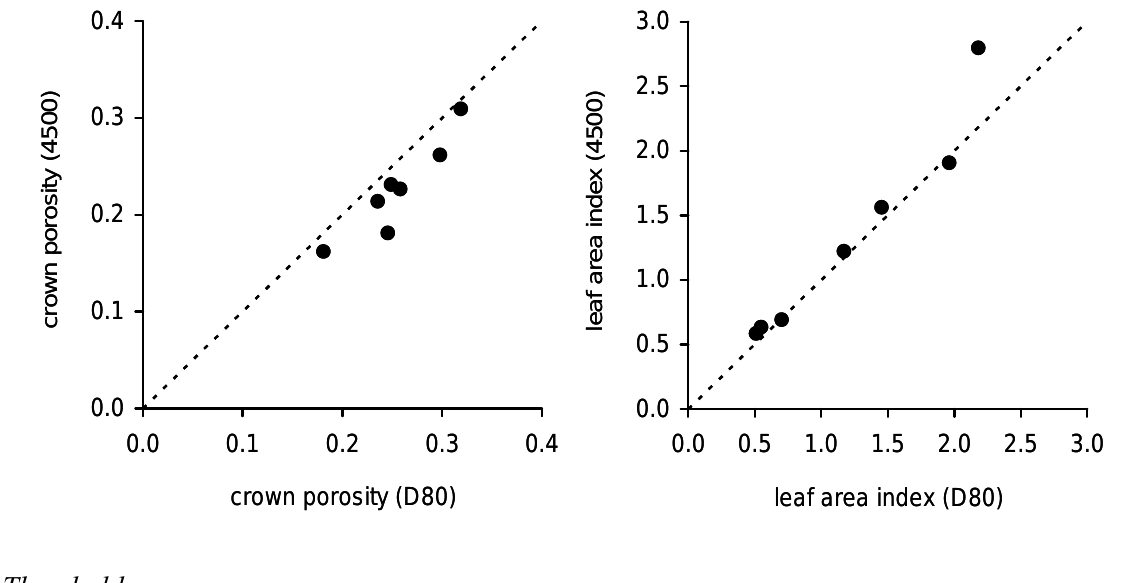
Figure 5. Comparison of crown porosity and leaf area index obtained from the Nikon D80 DSLR camera and from the Coolpix 4500 camera using DCP. Each data point is the mean of 25 images from the 4500 or 50 (medium and small) images from the D80. Standard errors (not shown) were between 0.01 and 0.02 for crown porosity and 0.08 and 0.15 for leaf area index. The dashed line is the 1:1